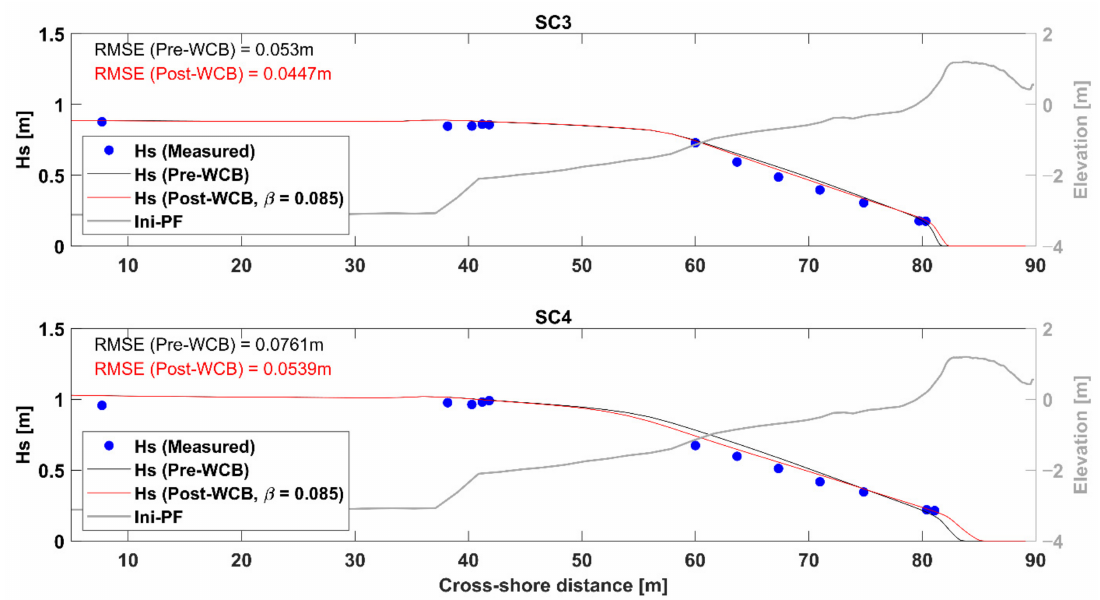
Figure 3. Hs of pre and post (optimized) WCB after storm conditions (SC3 and SC4): Measured (blue filled circle), pre- WCB (solid black line), and post-WCB (solid red line, beta = 0.085), and initial profile (solid gray